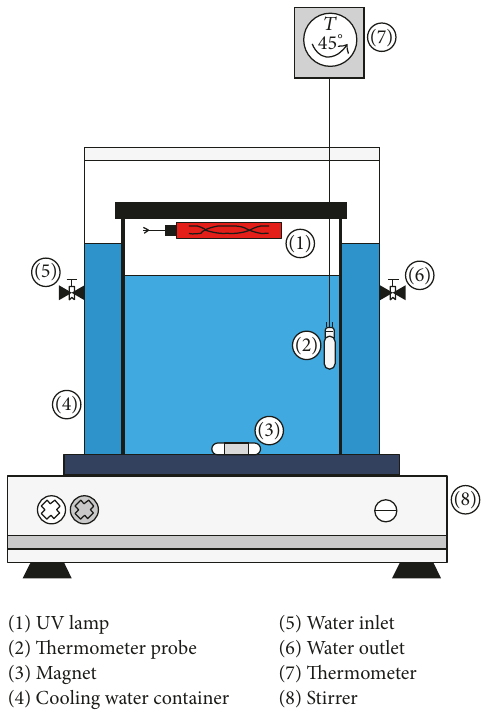
Figure 2: Setup for